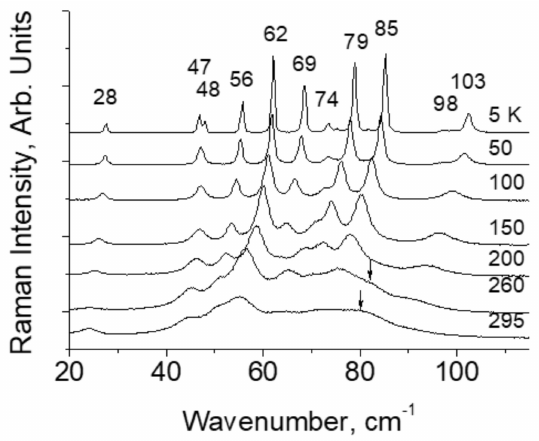
Figure 29. Low-frequency spectra of ibuprofen crystals at different temperatures [43]. The arrow marks the position of a new high-temperature mode at ~90 cm − 1 arising at Т ≥ 150 K.